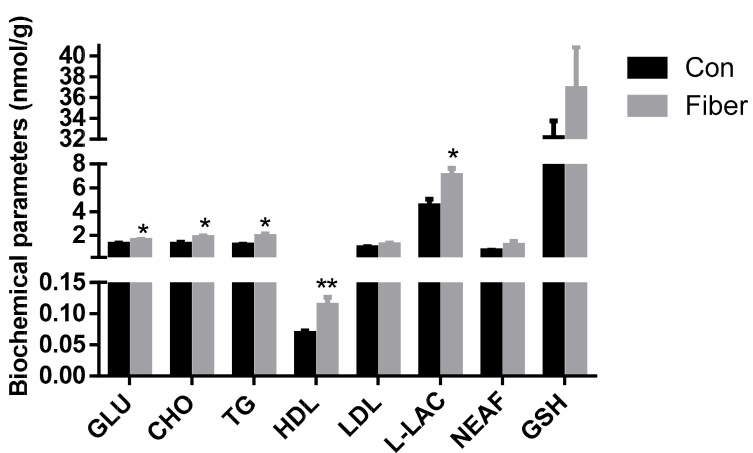
Figure 4. E ff ect of maternal fiber intake on the biochemical parameters of o ff spring. The values were expressed as mean ± SEM. * means p < 0.05, ** p < 0.01, as compared to normal control group. Con = control group, Fiber = Fiber group. GLU = glucose, CHO = cholesterol, TG = triglyceride, HDL = highdensitylipoprotein, LDL = lowdensitylipoprotein, l -LAC = l -lactate, NEFA = non-esterified fatty acid and GSH = l -Glutathione.